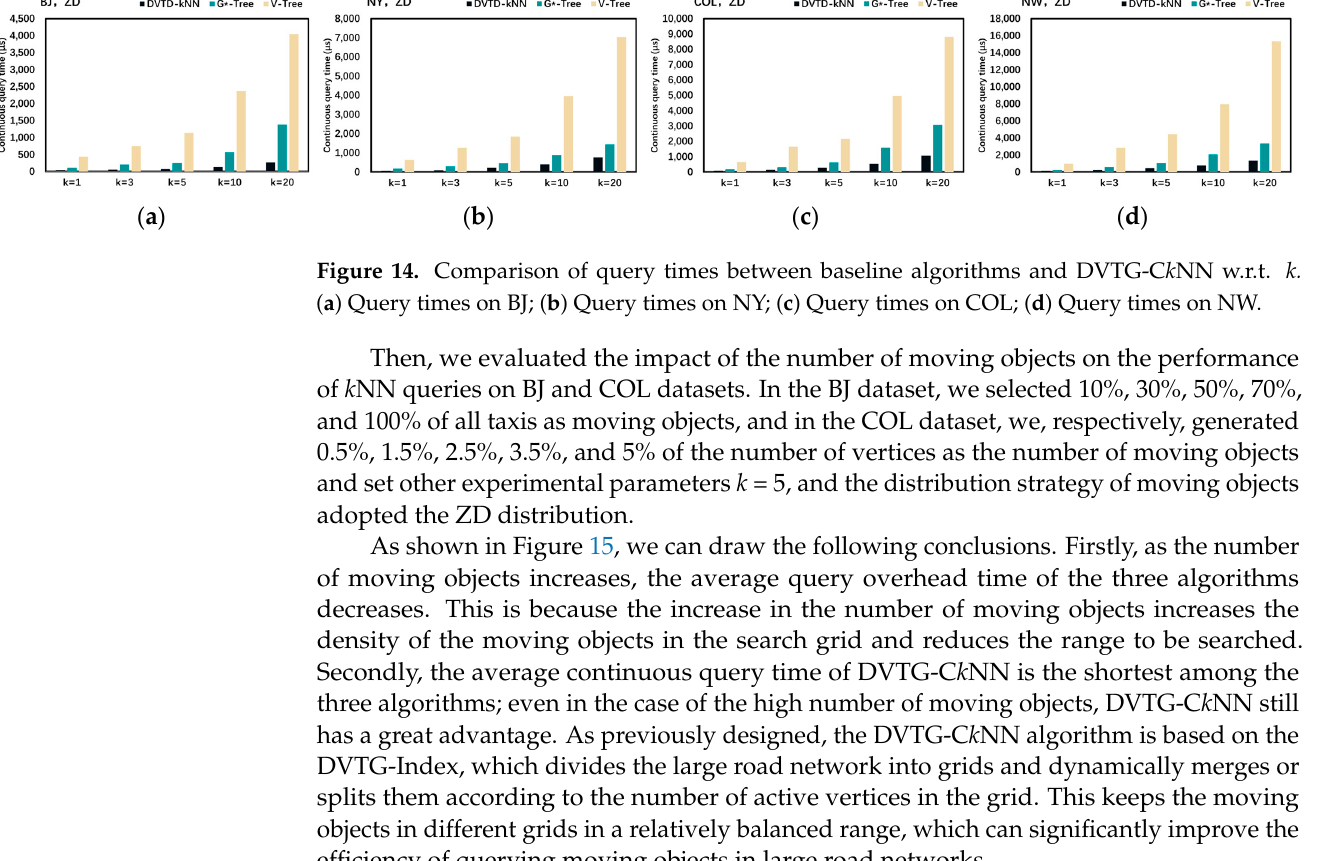
( d ) Figure 16. Comparison of query times between baseline algorithms and DVTG-C k NN under the three distribution strategies. ( a ) Query times on BJ; ( b ) Query times on NY; ( c ) Query times on COL; ( d ) Query times on NW. Finally, we evaluated the impact of different consecutive query times on the perfor- mance of k NN queries. We set the number of continuous queries as 1, 3, 5, 10, and 20, and the moving objects used the ZD distribution strategy. Other experimental parameters were k =5, 10% of all taxis as moving objects in the BJ dataset, and 2.5% of the number of vertices as the number of moving objects in the NY, COL, and NW datasets, and the mov- ing objects used the ZD distribution strategy. As shown in Figure 17, the average continuous query time of DVTG-C k NN is the shortest among the three algorithms. Especially after the number of continuous queries gradually increases, the performance advantage of DVTG-C k NN compared with the base- line algorithm is more obvious. This is because the DVTG-C k NN algorithm provides tra- versal for subsequent continuous queries through the query vertex queue. The boundary vertices in the queue are not updated as the position of the moving object changes. There- fore, the border vertex data in the queue can still be used again in continuous queries, and